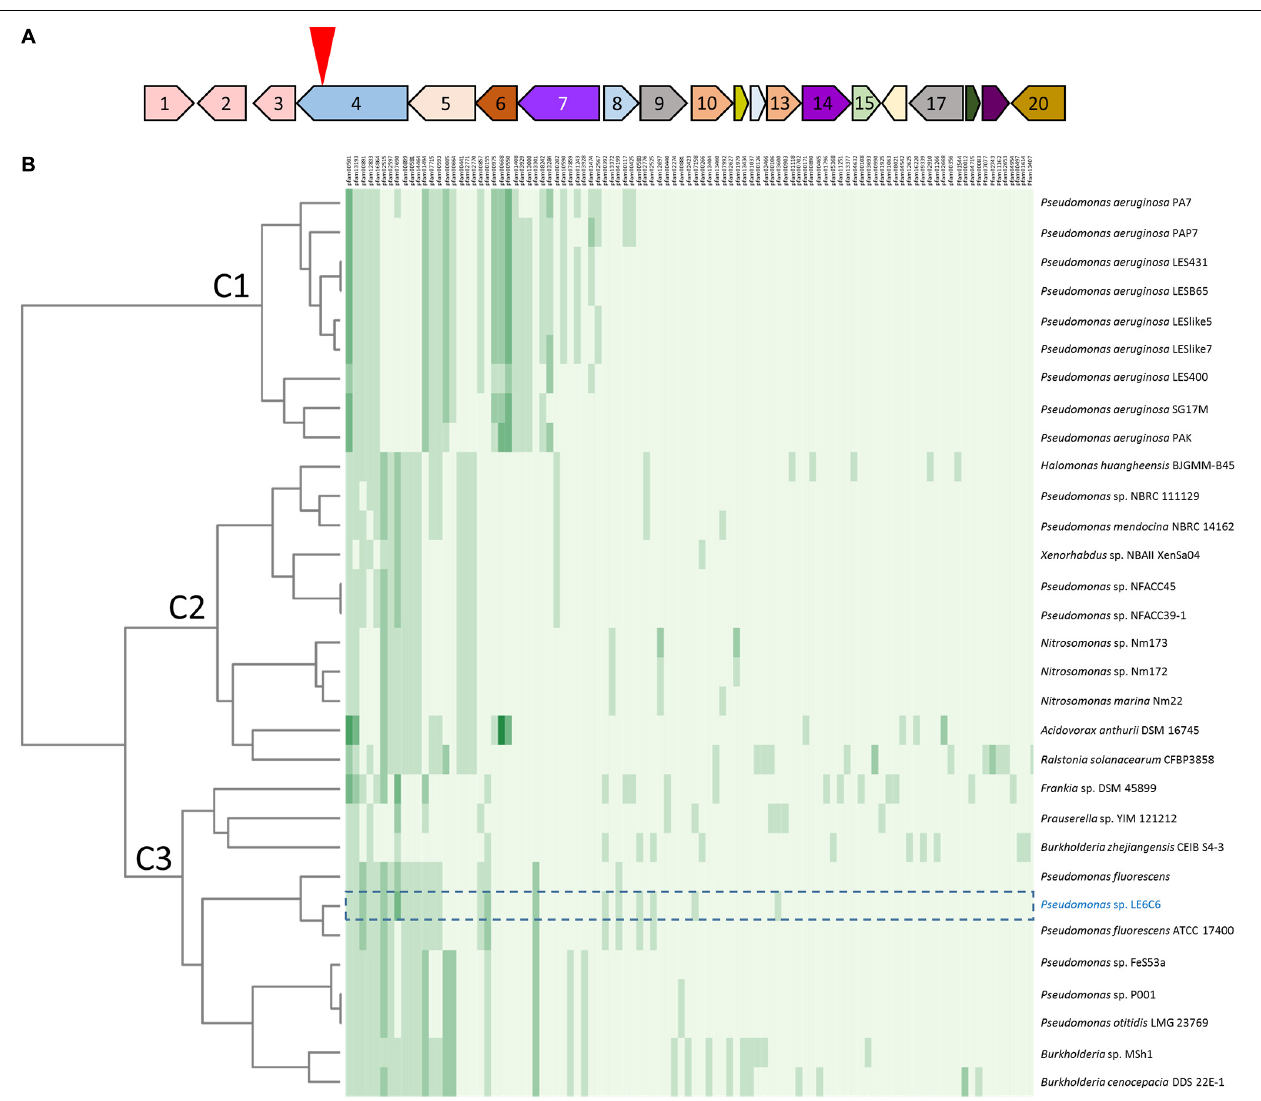
FIGURE 3 | Pfam similarity to the 06C 126 qbs gene cluster. (A) Strain 06C 126 qbs BGC is predicted to encode a low affinity siderophore. Numbers in open reading frames (ORFs) correspond to ORFs in Table 2 . The inverted red triangle indicates the site of transposon insertion. Same-colored ORFs represent identical Pfams. (B) Heat map of BGCs with similar Pfams to qbs BGC. Strain 06C 126 is highlighted in blue, and the BGC is outlined with a dashed line. Clade C3 represents BGCs with the most similar Pfams to the 06C 126 BGC. Numbers listed on the X -axis (top) correspond to Pfams in JGI ABC; predicted proteins and Pfams for strain 06C 126 BGC are in Table 2 . The phylogeny on the Y -axis (left) was determined by both Pfam similarity and number of Pfams in a BGC from the most similar gene clusters in JGI ABC. More than one Pfam of the same type can be found in a BGC and is indicated by green shading and represent 0, 1, 2, 3, 4, and 5 Pfams. Bacterial strains are listed on the right Y